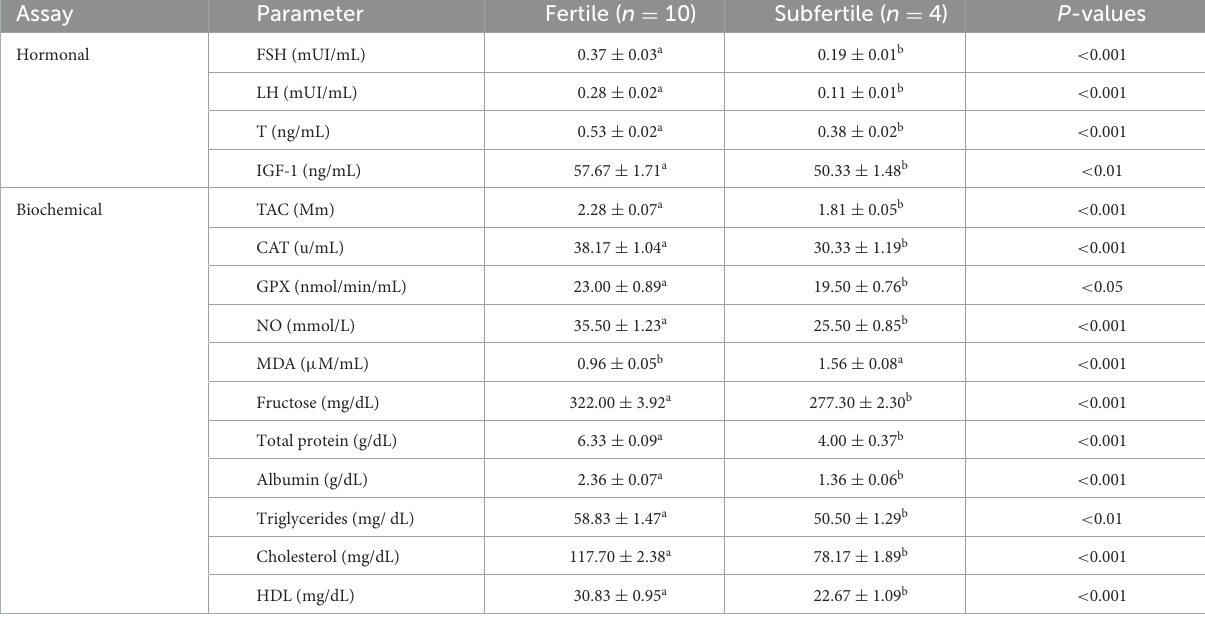
TABLE 2 Seminal fertility biomarkers (mean ± SEM) of fertile and subfertile buffalo bulls.